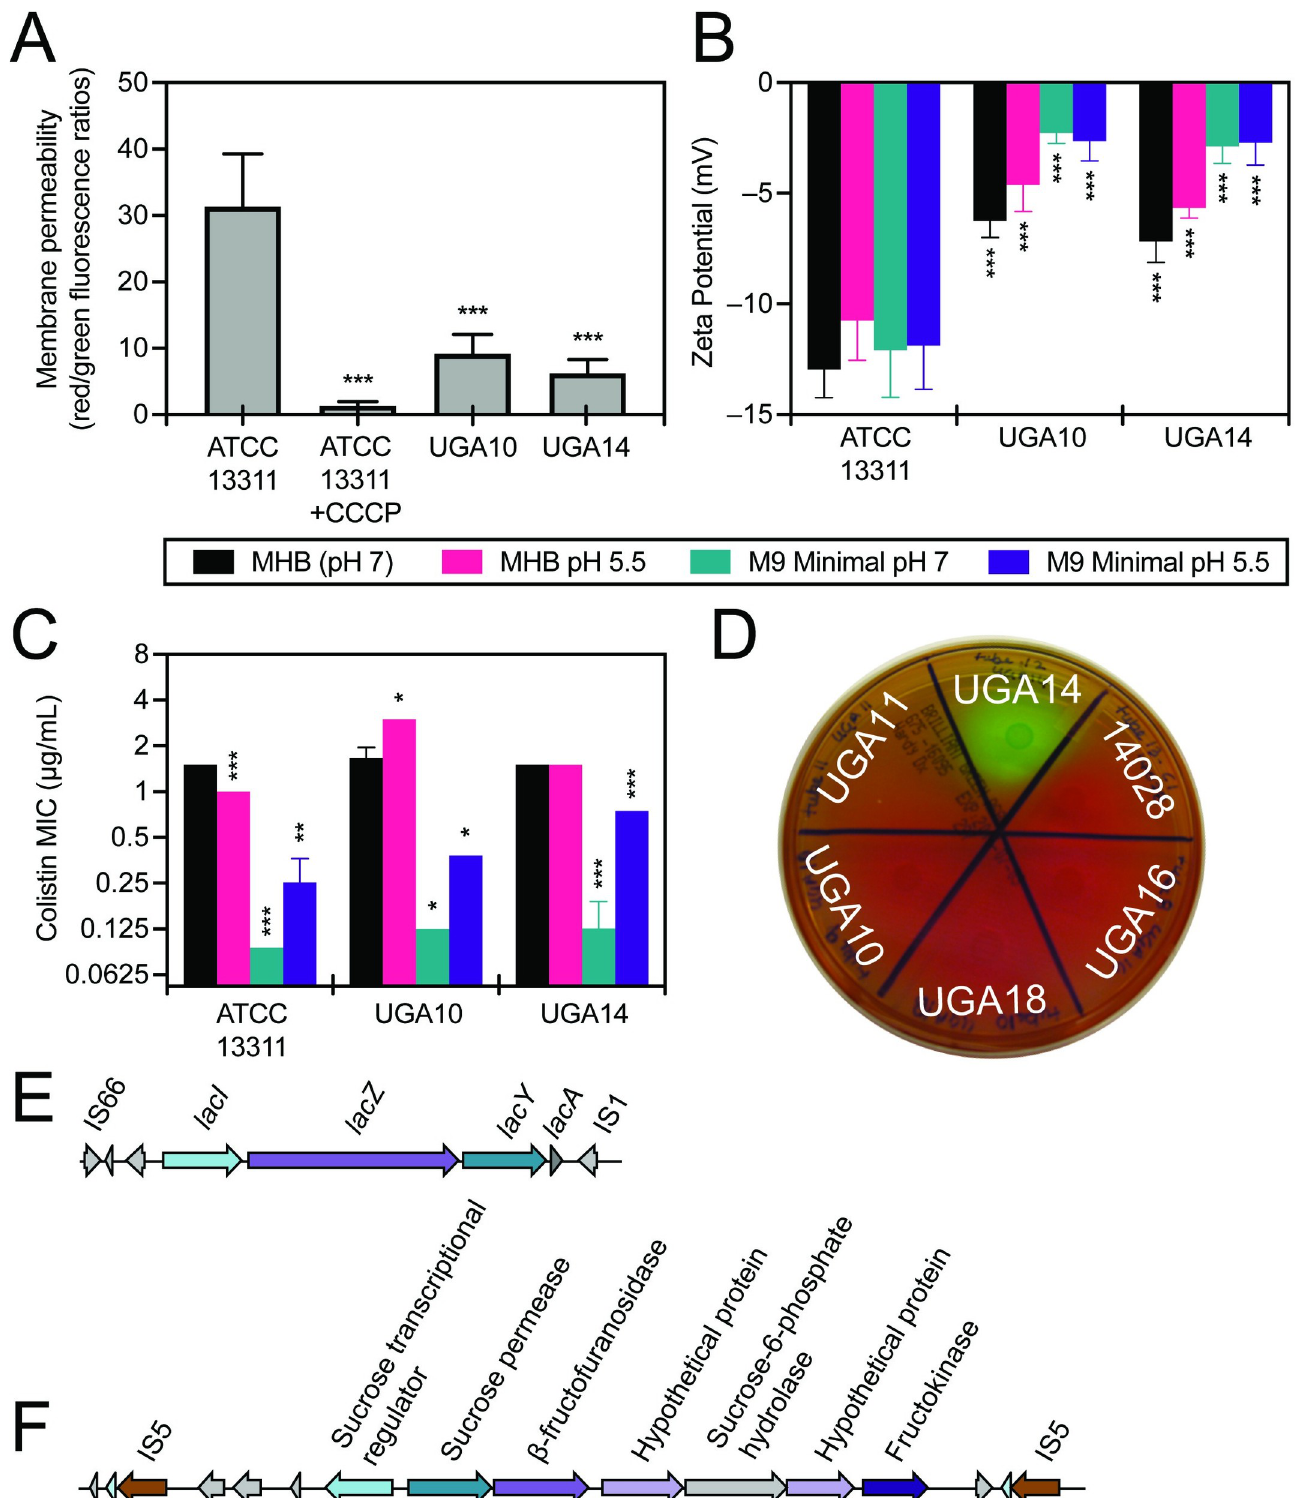
Fig 5. S . Typhimurium isolates UGA14 and UGA10 displayed altered membrane permeability and zeta potential compared to the antimicrobial sensitive and non-invasive ATCC 13311 strain. Both UGA14 and UGA10 displayed reduced (A) membrane permeability and a (B) more positive zeta potential compared to the reference strain ATCC 13311. Alterations in zeta potential were independent of growth conditions comprised of either Mueller Hinton Broth (MHB,